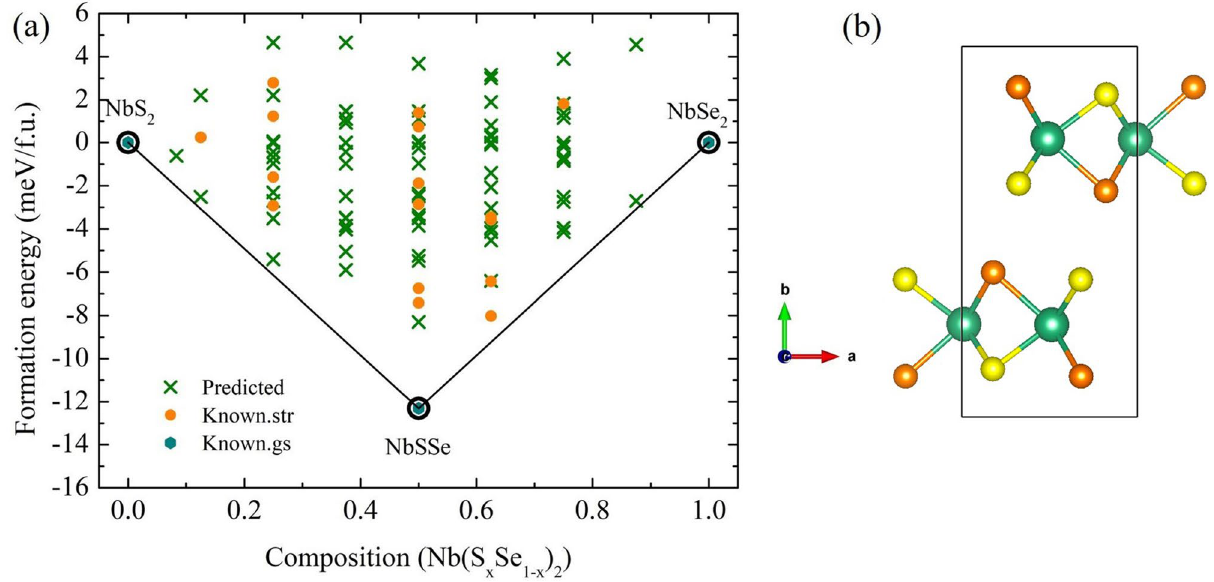
Figure 1. ( a ) The formation energy at ambient pressure. The predicted structures (the cross symbols) refer to structures whose energy has not yet been calculated from DFT, the known str (the circle symbols) refers to structures whose energy has been calculated from DFT, and the known gs (the diamond symbols) refers to the ground states energy that have so far been confirmed by DFT, showing a line on the convex hull. ( b ) The Nb(Se 0.5 S 0.5 ) 2 structure, where the orange sphere, the green sphere and the yellow sphere represent Se, Nb and S, respectively [drawn by VESTA (ver. 3.4.7) 45 (URL https:// jp- miner als. org/ vesta/ en/ downl oad.